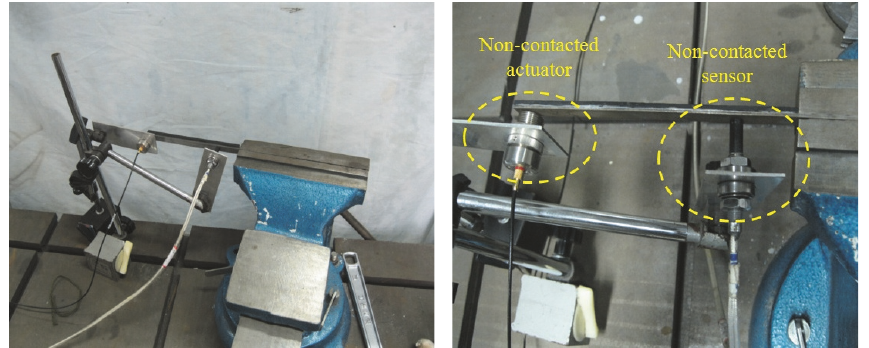
Figure 4: Arrangement of the noncontacted actuator and